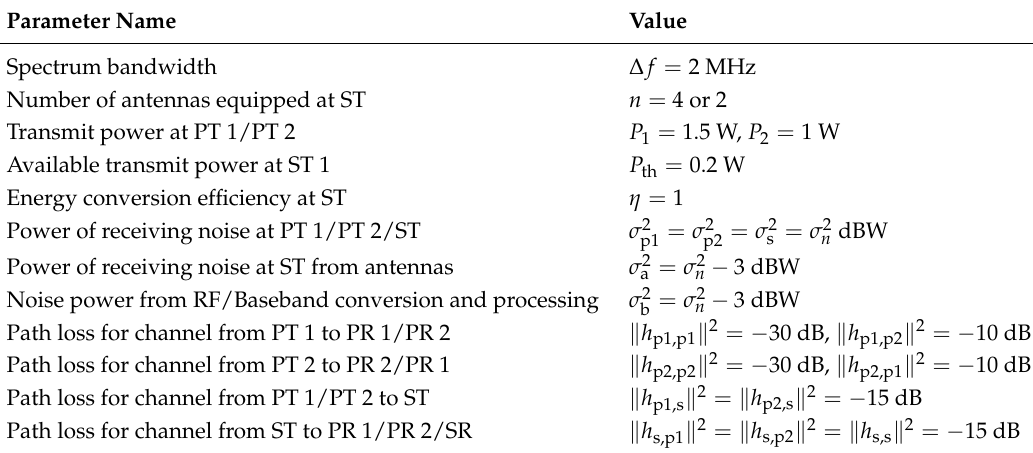
Table 1. Simulation